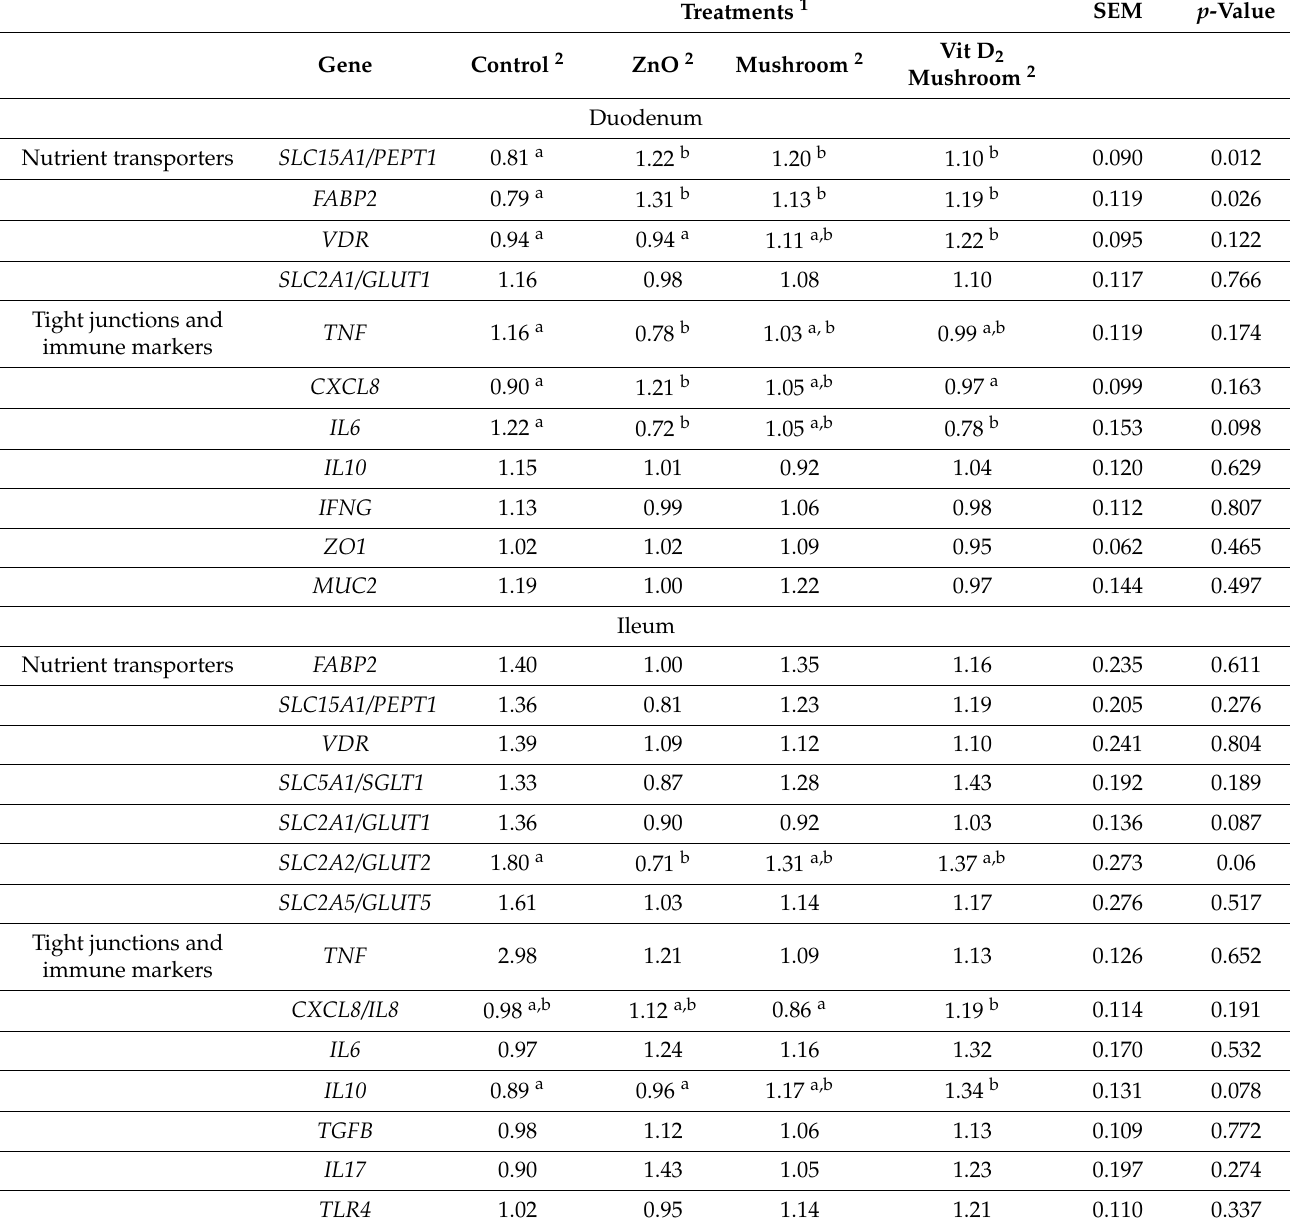
( p < 0.05) in the ileum compared with all other groups. Table 10. The effects of dietary treatment on the expression of nutrient transporters, immune markers and tight junction genes in the duodenum and ileum; the expression of appetite regulators in the duodenum and ileum (least square means with their standard